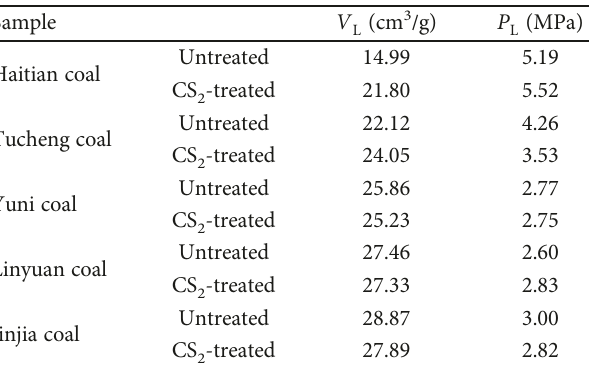
Table 4: Langmuir constants of untreated and CS